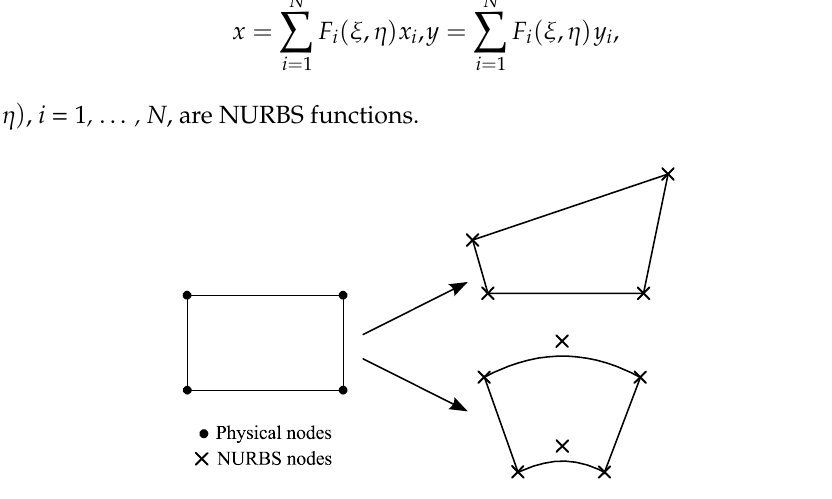
Figure 7. Example of free-form element shapes.